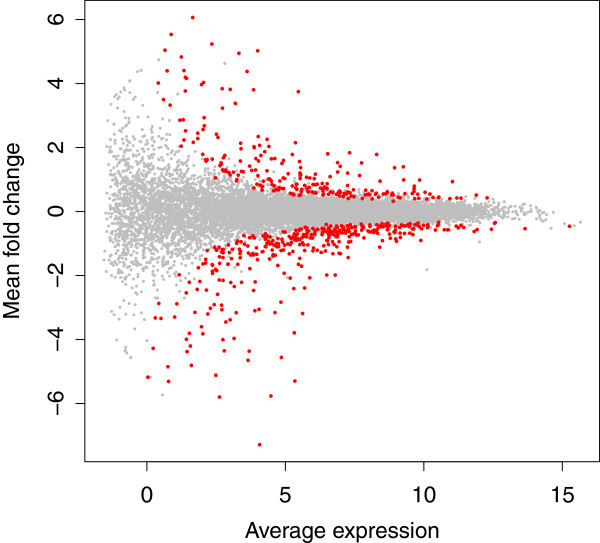
MA plot for DESeq. The base 2 logarithm of average expression across all samples for a feature is plotted vs the base 2 logarithm of fold-change. Points that are significantly different with a fdr less than 0.05 are in red, all others are in gray.